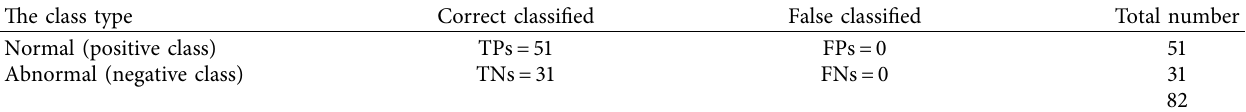
Table 5: The confusion matrix of the first SVM classifier, in the testing of normal and abnormal.